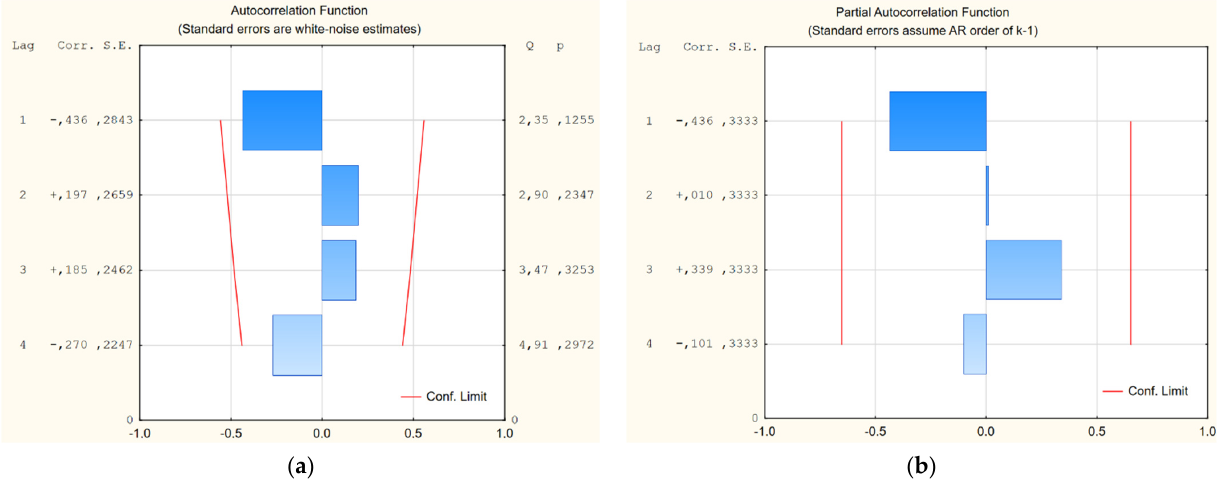
Figure 8. Residual number of the equation of compressive strength: ( a ) autocorrelation function; ( b ) partial autocorrelation function.